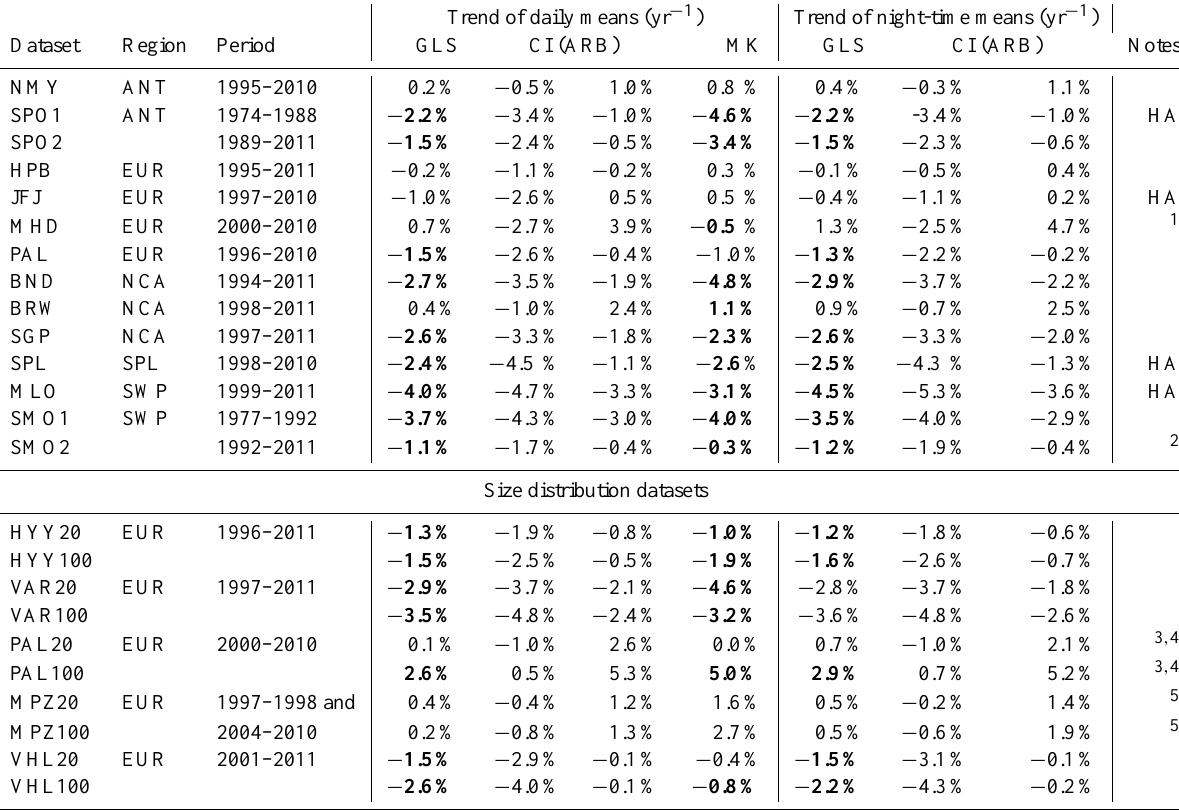
Table 2. Trends of aerosol number concentrations for the entire period available for each dataset. Trends for daily means are calculated in logarithmic space for the GLS method (Generalized Least Squares). The confidence intervals (CIs) for the GLS method are calculated using an autoregressive bootstrap (ARB) method, showing the 5th and 95th percentile CIs. Mann-Kendall trends and significances are calculated in linear space, and the relative trends are obtained by dividing the absolute trend by the sample median concentration. Night time trends are calculated from night time (21:00–09:00 local (solar) time) means. The bolded trends have statistically significant sign (CIs are the same sign for GLS trends, for MK trends the trend passes the significance test with p < 0 . 05, see companion paper for MK test details). For data quality assurance, see